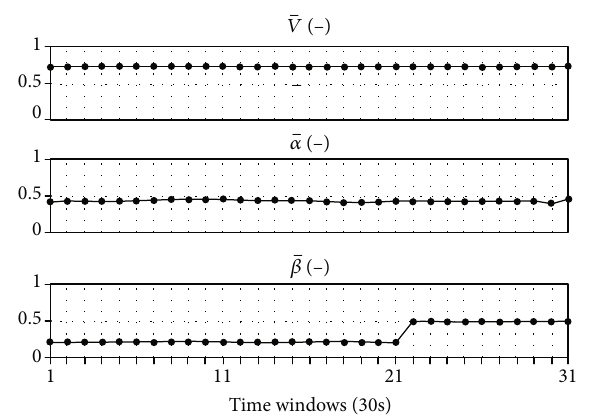
Figure 13: Normalized fl ight records for features visualization; as in Figure 4, the data has been downsampled to 1Hz; the sideslip drift fault occurs at last 1/3 of the window, i.e., 21 ~ 31s.